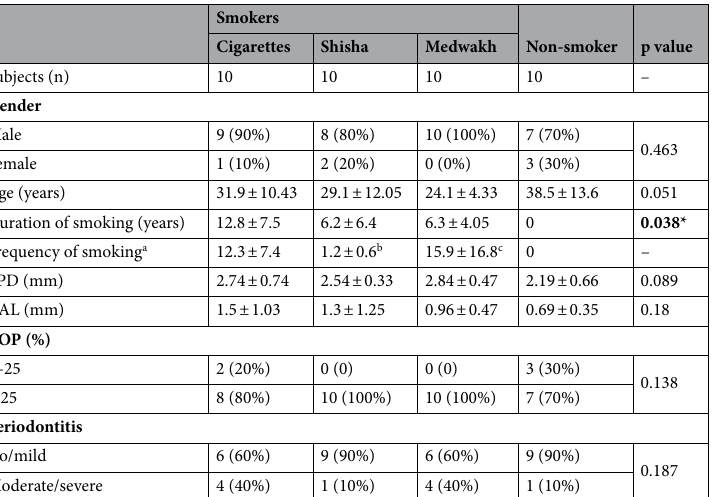
Table 1. Demographics and periodontal status of the study participants subdivided into four groups based on smoking status. Values express n (%) or mean ± SD. PD pocket depth, CAL clinical attachment loss, BOP bleeding on probing. *Significant at p < 0.05, non-smoker vs any smoker. a Cigarettes/day, times per day for shisha and medwakh. Statistical comparison was not done due to the difference in the units of measurement (number of cigarettes/day, times/day with number of heads for shisha, times/day with number of puffs for medwakh). b For shisha: 0.8 ± 0.3 heads/time. c For medwakh: 6.4 ± 8.5 puffs/time.